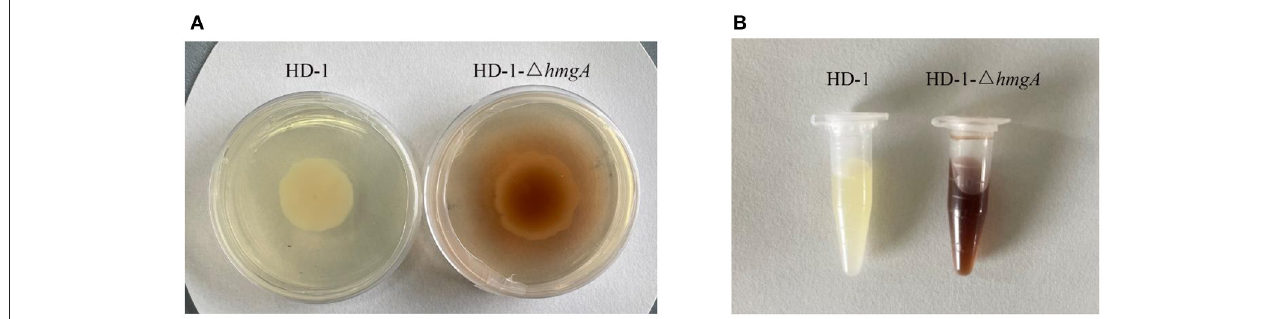
FIGURE 2 | Melanin observation of B. thuringiensis HD-1 and HD-1- 1 hmgA . (A) Strain HD-1 and HD-1- 1 hmgA cultured on LB plate for three days. (B) Strain HD-1 and HD-1- 1 hmgA cultured in liquid LB medium for three days.